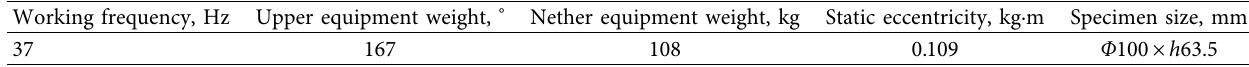
Table 6: Working parameters of the VTM method.